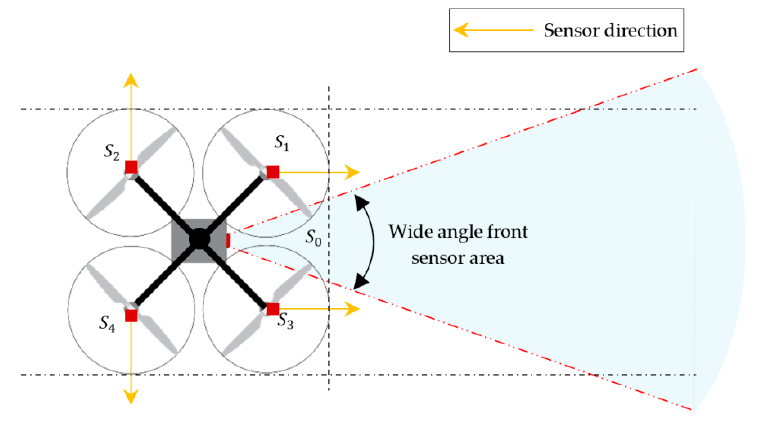
Figure 5. Sensor setup for